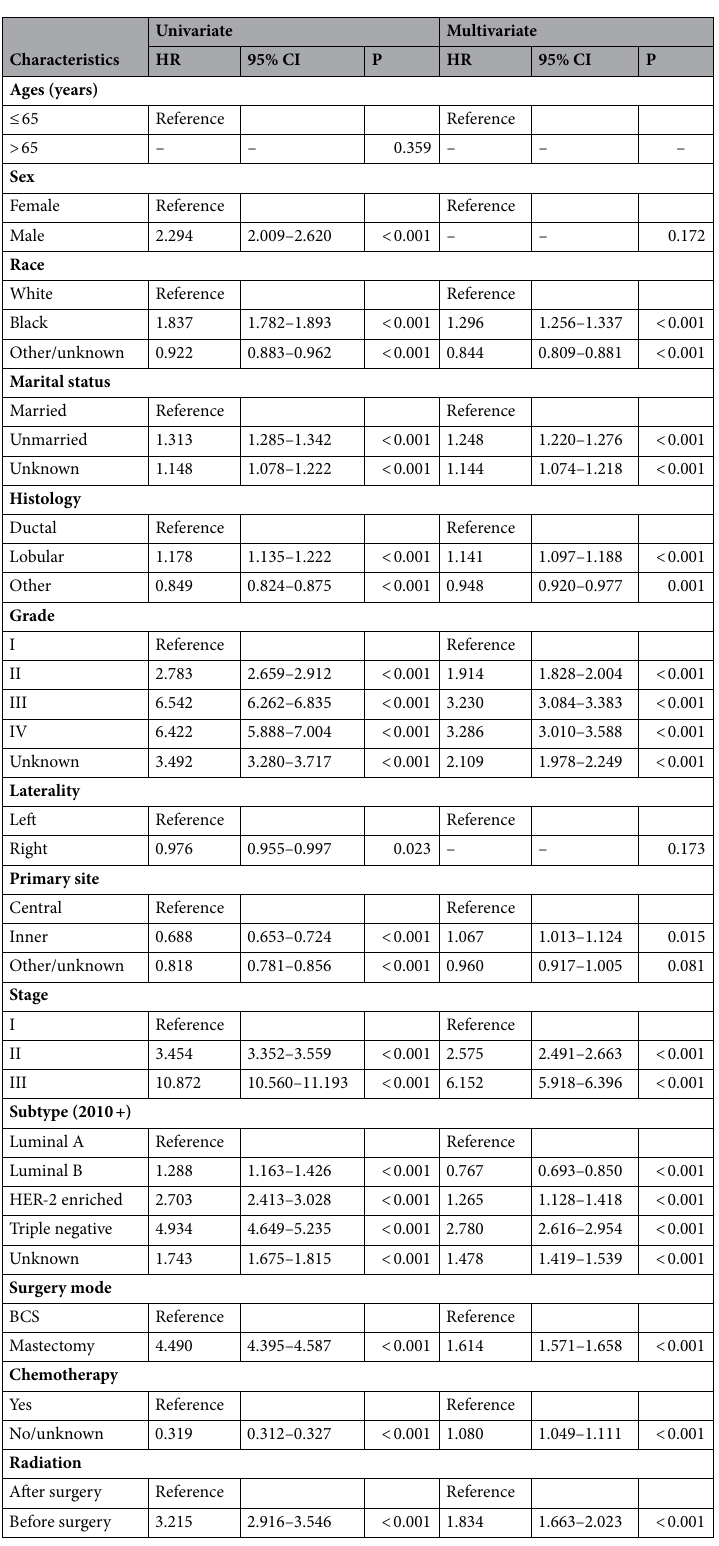
Table 3. Univariate and multivariate Cox regression of breast cancer-specific survival in the whole